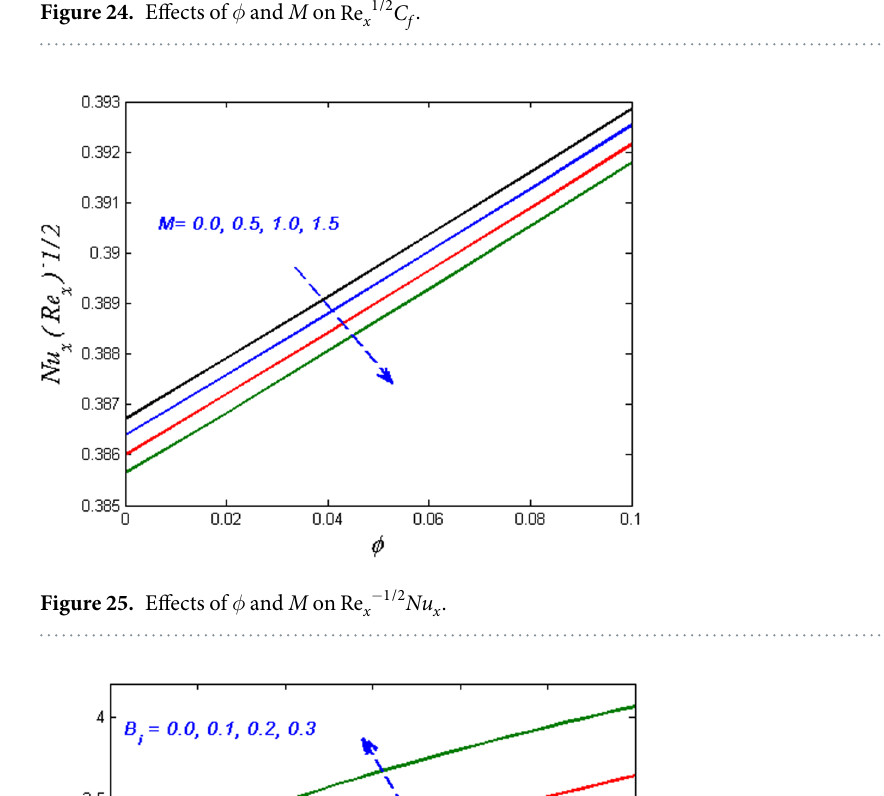
Figure 24. Effects of φ and M on